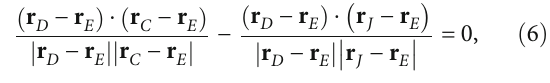
Figure 8. It can be used to control the motion of the adjacent truss units. The rotation angles of two adjacent longeron rods connecting the sliding hinge with respect to the batten